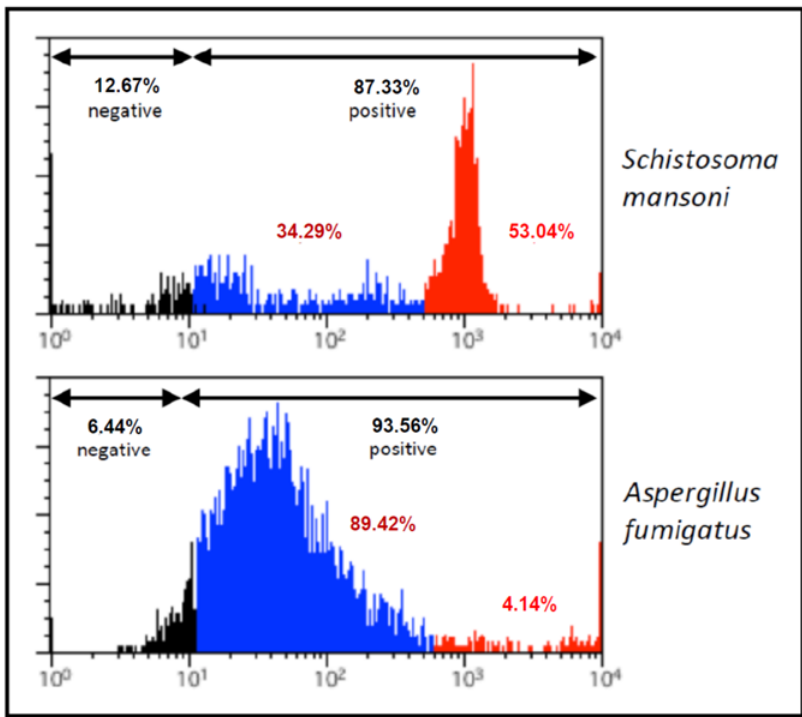
Figure 3. Flow cytometry analysis of Schistosoma mansoni cercariae and Aspergillus fumigatus conidia counts after incubation with the α -Gal-specific monoclonal antibody M86 (primary antibody) and FITC-conjugated goat anti-mouse IgM (secondary antibody). The organisms are represented in a histogram to evaluate the relative expression of α -Gal. Unstained cells served as a negative control (black). Different proportions with low (blue) and high (red) levels of α -Gal were observed in both agents.